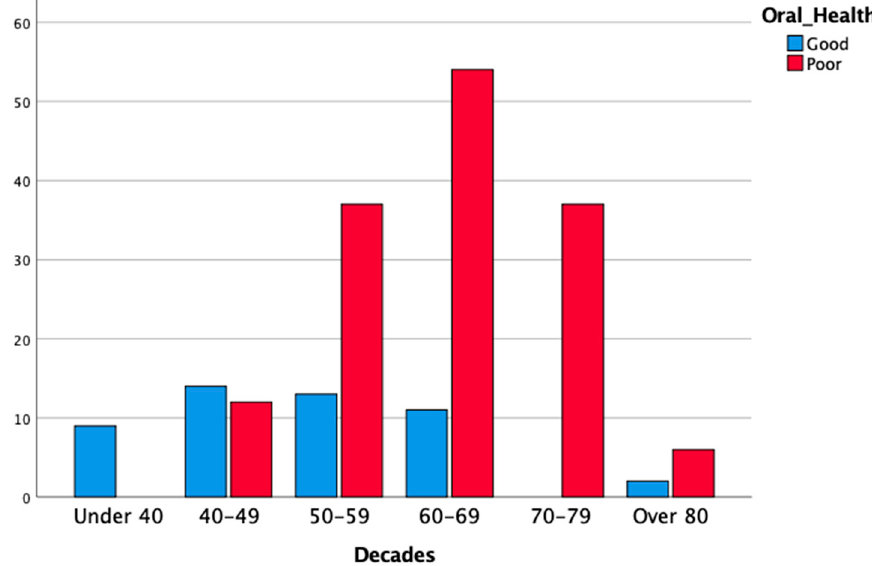
Figure 6. Distribution of OH status according to age of the patients (in decades).